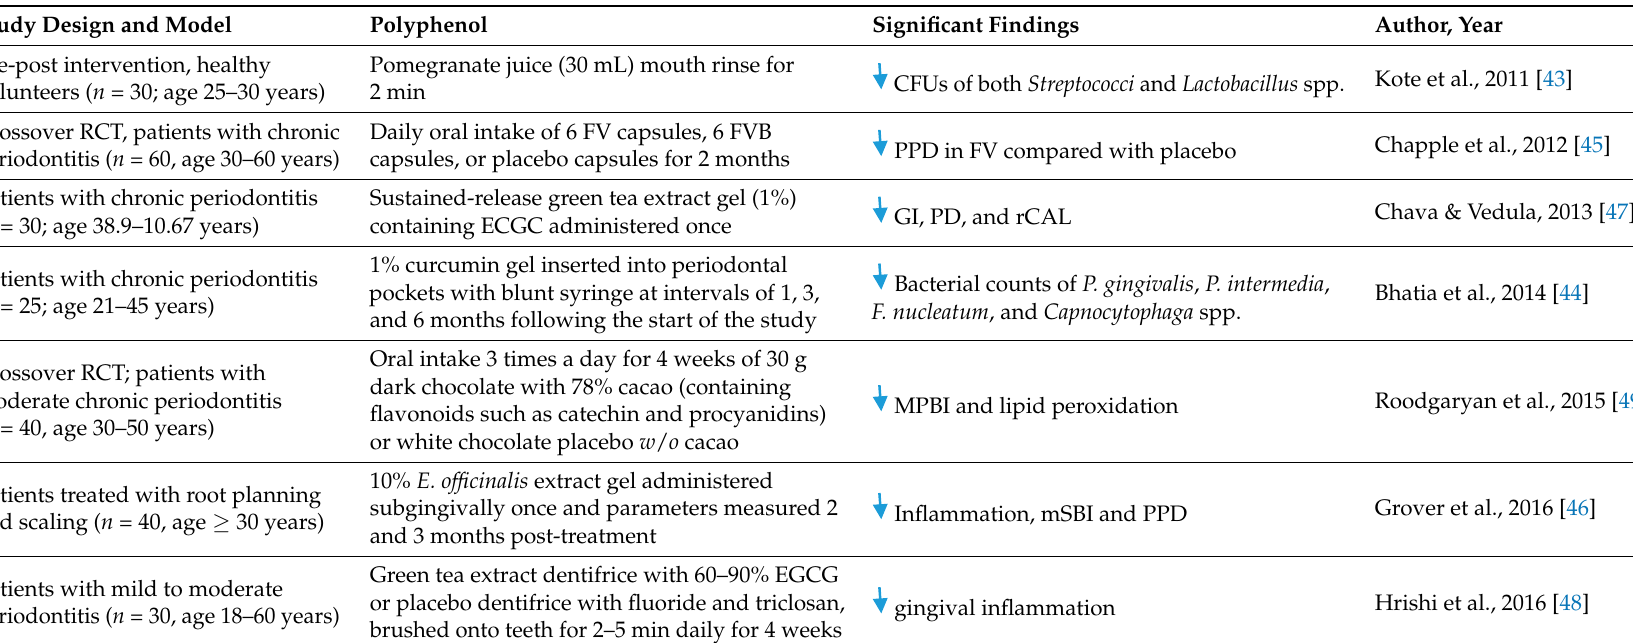
Table 2. Polyphenols as antioxidant/anti-inflammatory/antimicrobial agents in periodontitis: experimental animal models. Study Design and Model